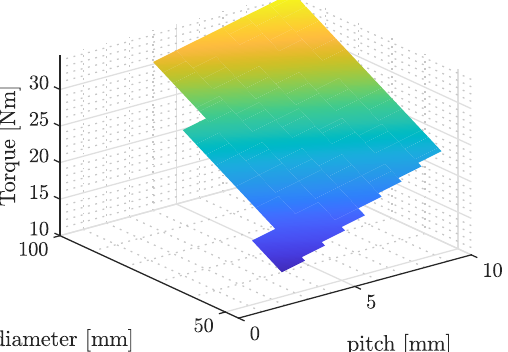
Figure 6. Constrained screw torque T results as function of pitch p and diameter d .